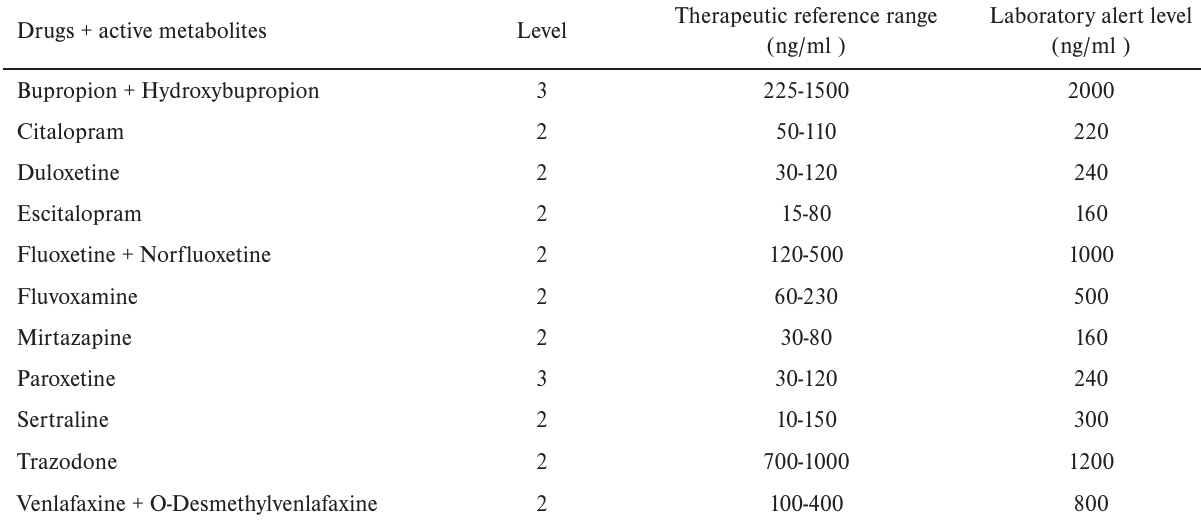
Table 5. Recommended therapeutic reference ranges, laboratory alert levels and levels of recommendation for TDM(ref. 9 ).